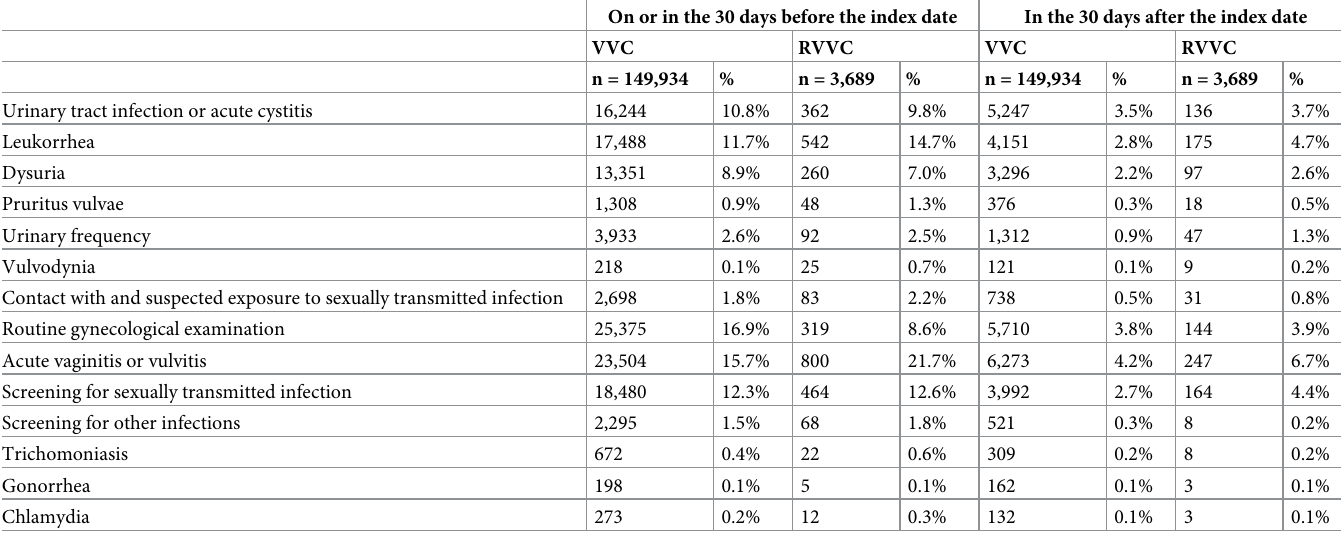
Table 2. Vulvovaginal candidiasis-related symptoms and conditions.